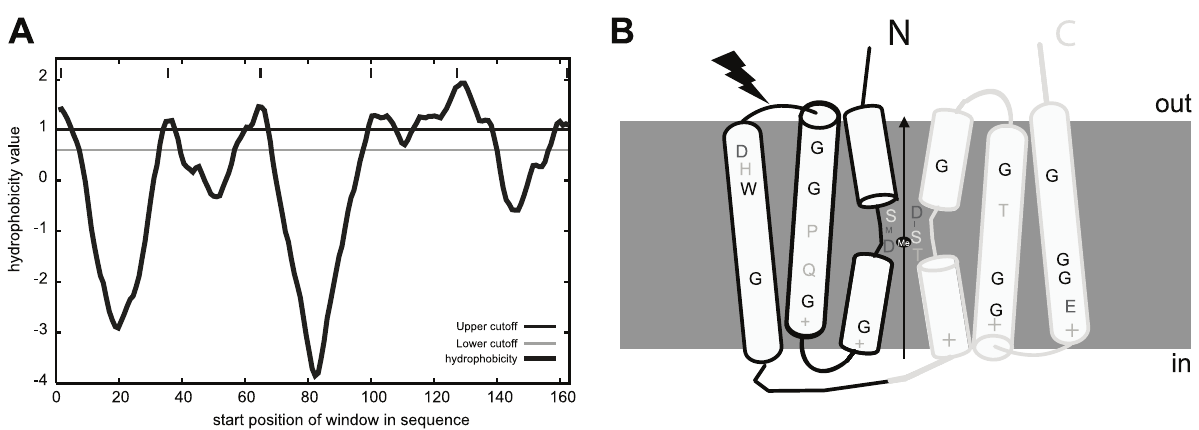
Figure 4. MntX identifies a family of predicted bacterial metal transporters. A) MntX Xc hydrophobicity plot based on the Goldman, Engelman, Steitz hydropathy scale, using core and wedge windows of 14 and 4 a.a. residues, respectively. B) Proposed model of structure-function relationships in MntX deduced from transmembrane topology prediction and evolutionary sequence analyses. MntX inverted structural symmetry and pattern of sequence conservation suggest a functional interface that may act as a conformational switch for metal transport. The black lightening form represents the localization of the truncation of MntX Ng .